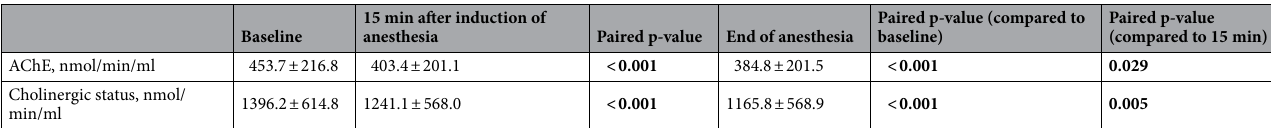
Table 2. Cholinesterase activity at baseline, 15 min after induction of anesthesia and at the end of anesthesia. AChE measurement achieved after incubating the samples with tetraisopropyl pyrophosphoramide a specific ButyrylCholinestersase inhibitor. Followed by spectrofluorometry using ACh analog-acetylthiocholine (ATCh). Cholinergic Status (CS) spectrofluorometry using ACh analog- acetylthiocholine (ATCh), without incubating with tetra isopropyl